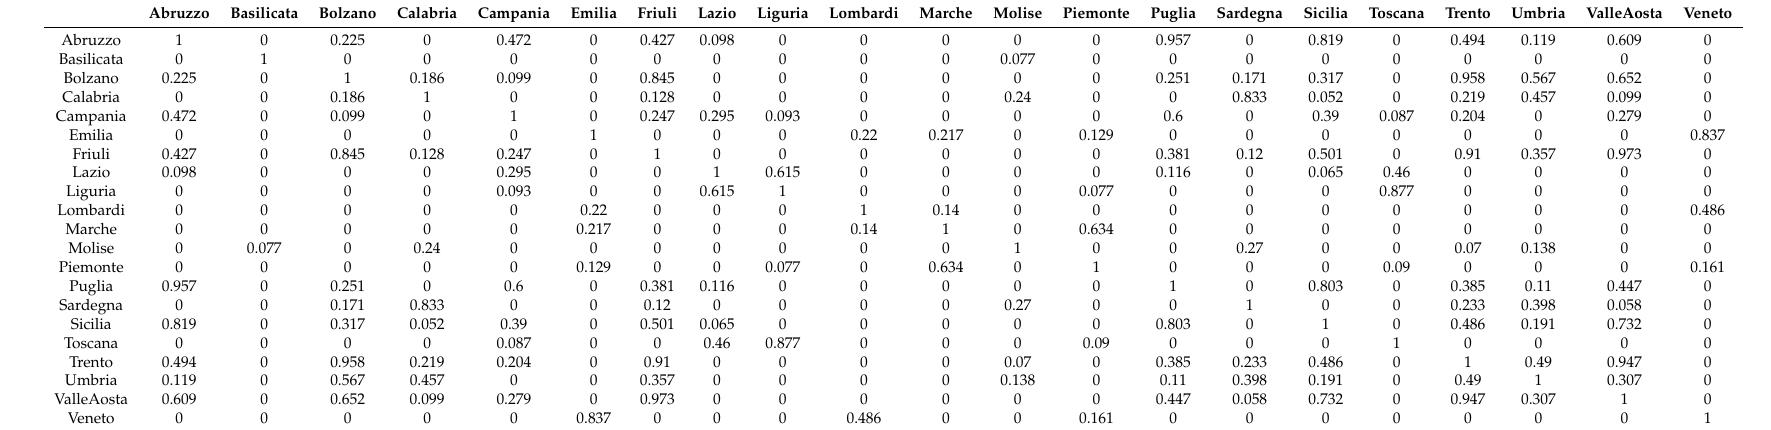
Table A13. Similarity values of Total Hospitalized network in the study period.